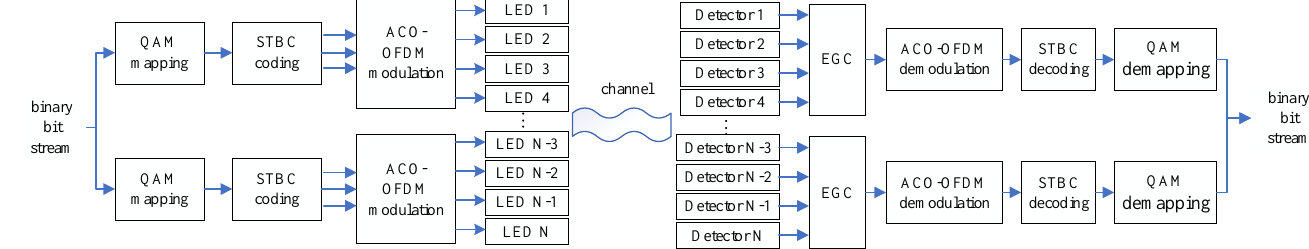
Figure 1. Underwater optical imaging communication system model.